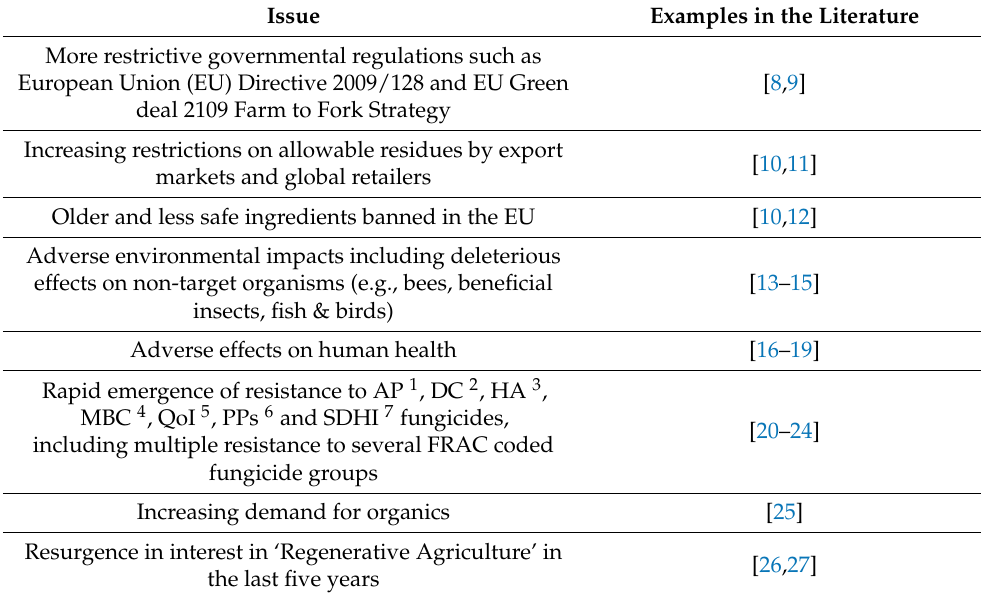
Table 1. Factors cited as the rationale for the urgent need for alternatives to synthetic pesticides and supporting